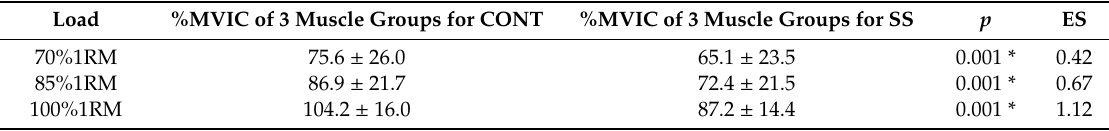
Table 2. Post hoc analysis for the main interaction of two conditions vs. three loads.